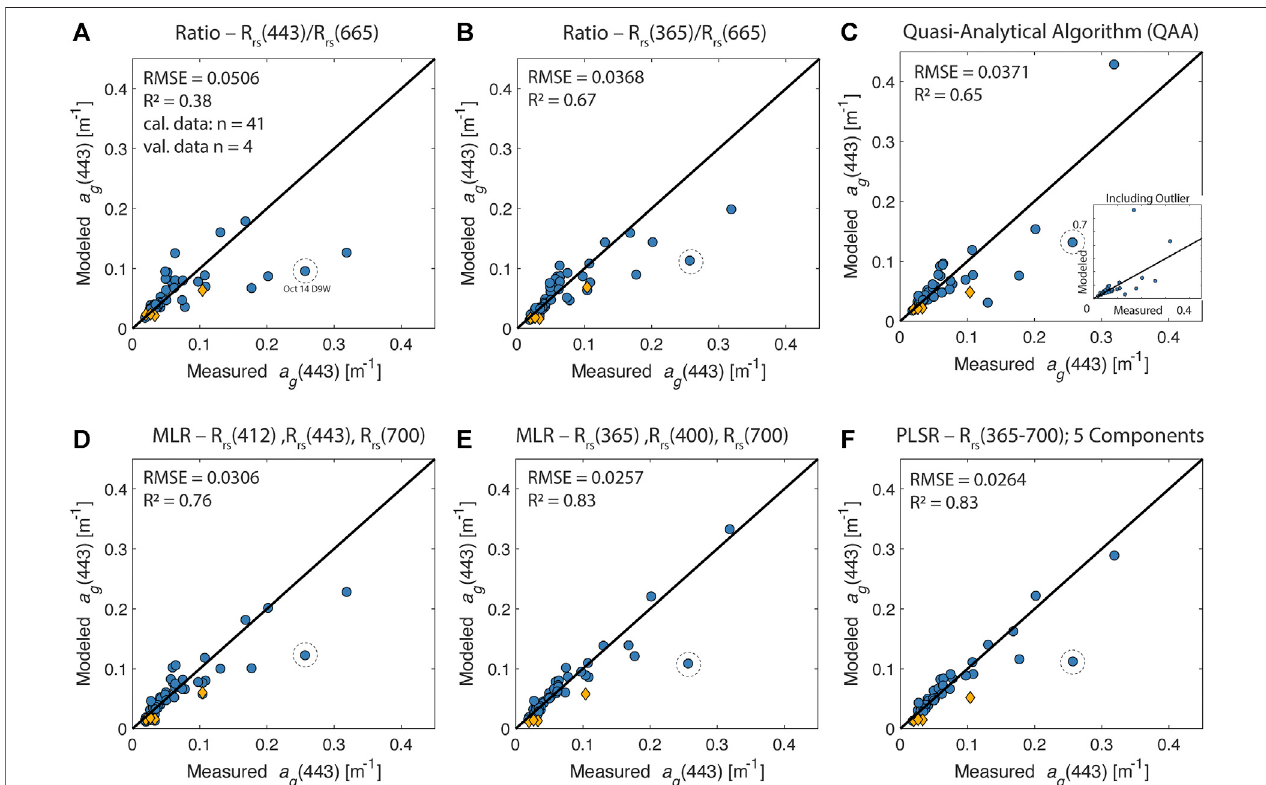
FIGURE 8 | Performance comparison of six different a g (443) algorithms. In-situ data used for calibration ( n (cid:2) 41) are displayed as blue circles, and end-to-end validation points comparing measured a g (443) to inferred a g (443) from nearest neighbor PRISM pixels ( n (cid:2) 4) are displayed as orange diamonds. Most of the a g (443) algorithms presented here, with the exception of the QAA, are empirical and were developed using coincident in-situ measurements of R rs and a g (443): (A) log-log fi t on blue-red band ratio R rs (443)/ R rs (665), (B) log-log fi t on UV-red band ratio R rs (365)/ R rs (665), (C) the QAA algorithm v.6, which exhibited one major outlier and is plottedwithoutittofacilitatecomparison(insetplotincludesoutlier), (D) log-logvisible-onlymultiplelinearregression(MLR)on R rs (412), R rs (443), R rs (700); (E) log-logUV- visibleMLRon R rs (365), R rs (400), R rs (700),and (F) alog-logpartial-least-squareregression(PLSR)onthefullspectrum R rs (365 – 700),usingthe fi rst fi vecomponents.The sample collected at station D9W on October 14 was an outlier, with low inferred a g (443) relative to measured a g (443) for all algorithms. This sample is indicated with a dashed